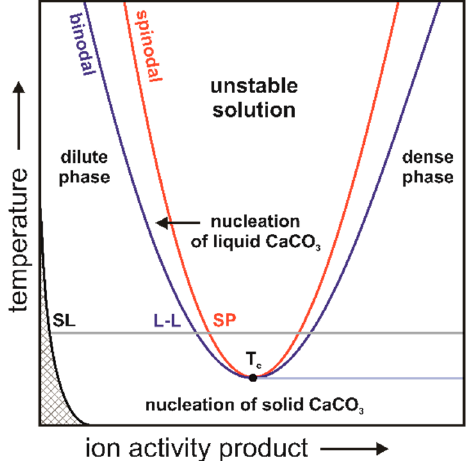
Figure 3. Schematic representation of the calcium carbonate phase relationships. The grey line represents an example solubility line (SL) of different polymorphs at constant temperature, the grey, checkered field corresponds to the unsaturated solution field, the L-L line represents the binodal (blue) and SP spinodal (red) lines, and T c is the critical temperature point [120].